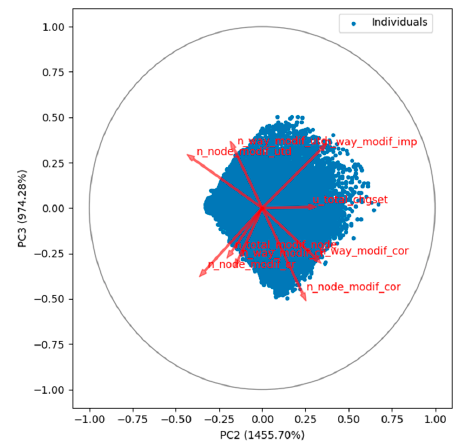
Figure 3. Explained variance for choosing the number of principal components.